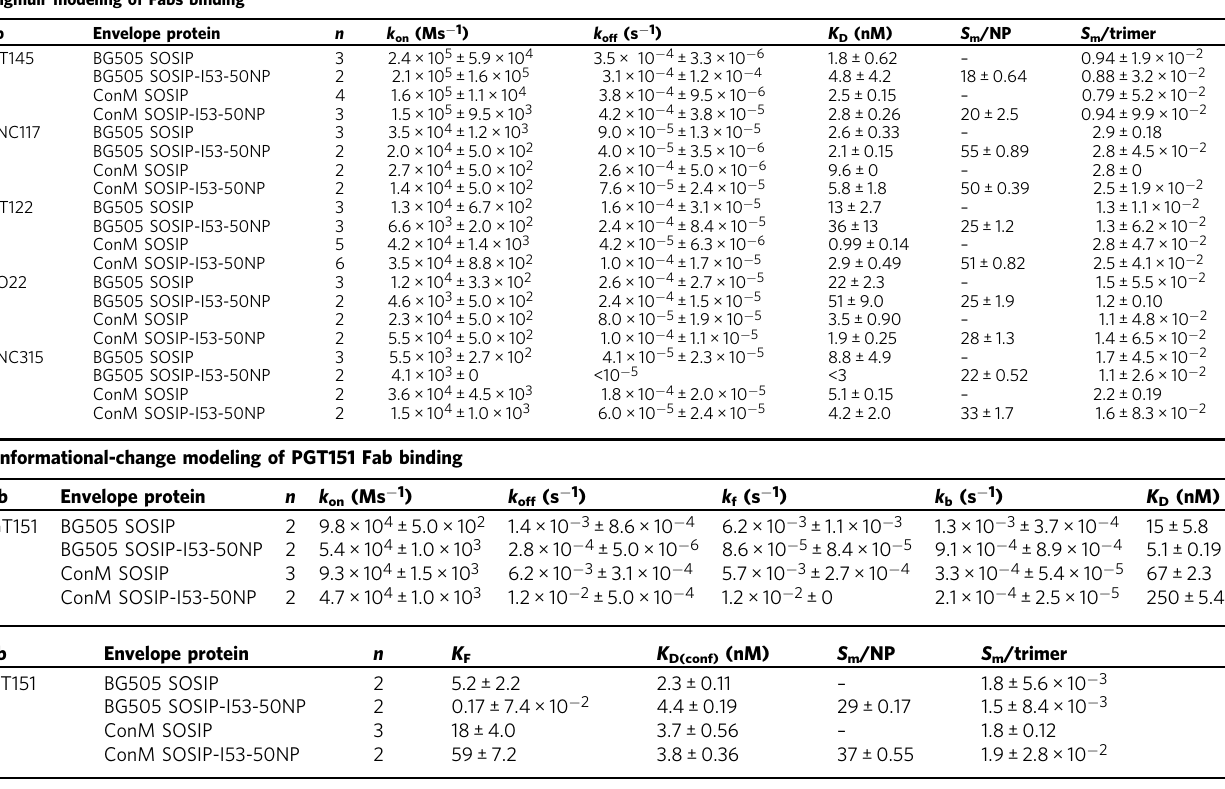
Table 3 Kinetics and stoichiometry of Fab binding to SOSIP trimers and SOSIP-I53-50NPs Langmuir modeling of Fabs binding